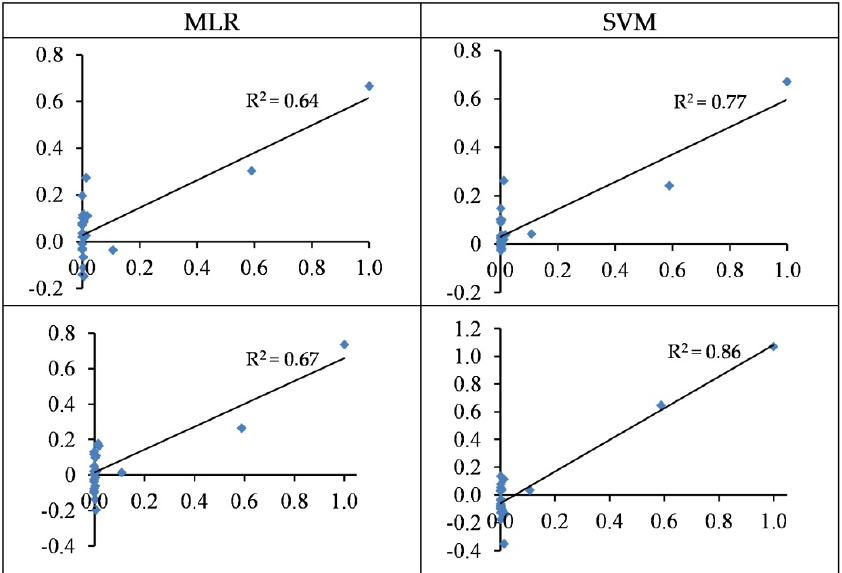
Figure 9. The standardized values (between 0–1) of the observed (horizontal axis) and the predicted (vertical axis) concentration of Cd based on wavelengths (top) and spectral indices (bottom) in the testing sets of the SVM and MLR methods.